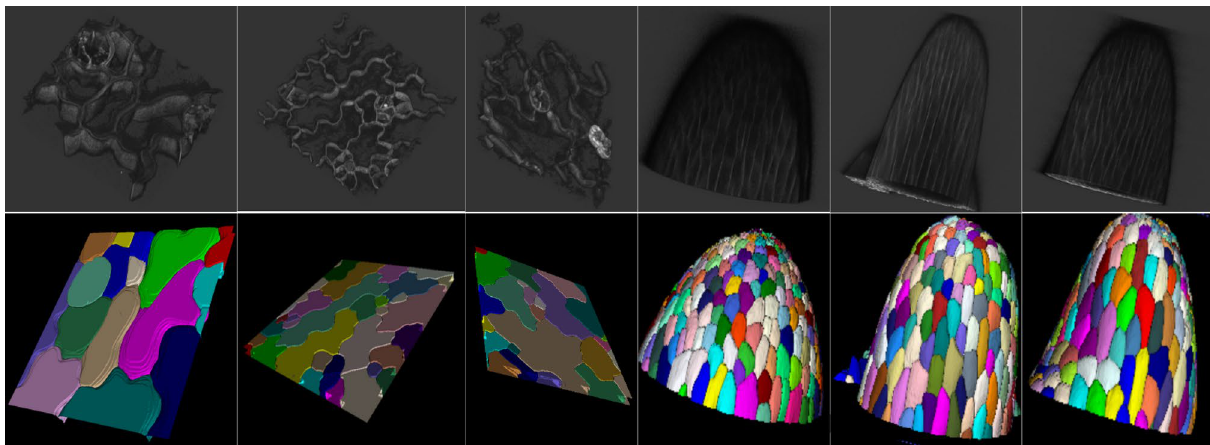
samples are from Dataset 2.